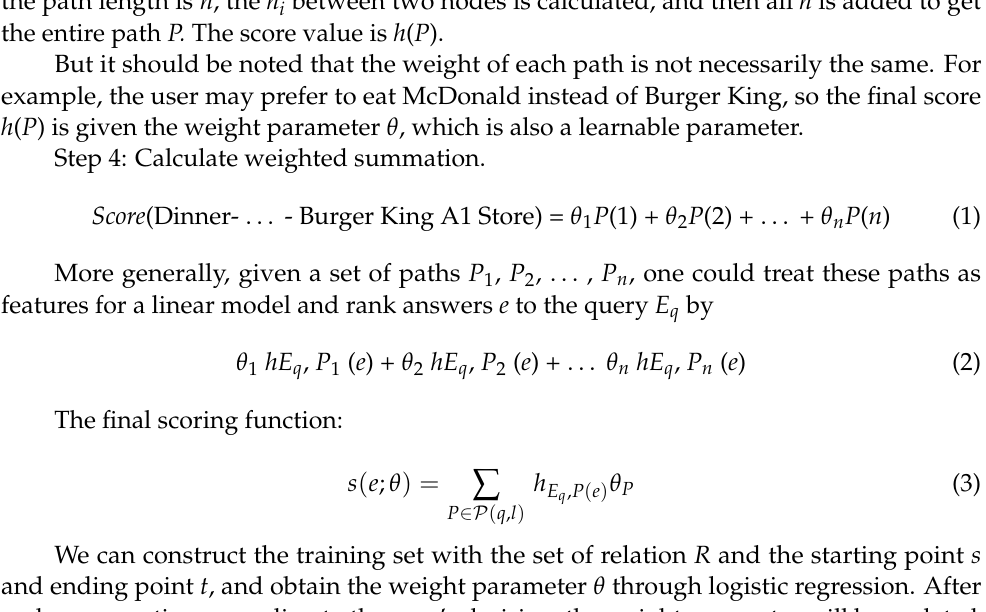
Figure 8. The part of knowledge graph in step 2 and step 3.